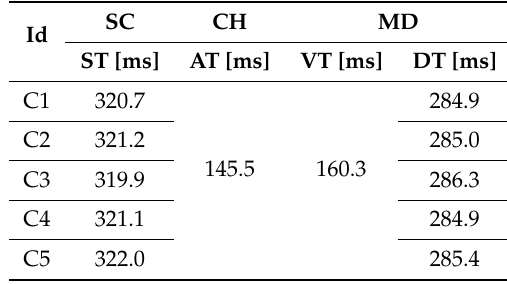
Table 4. Computational time for aggregate-signcryption. Legend: SC: smart camera, CH: